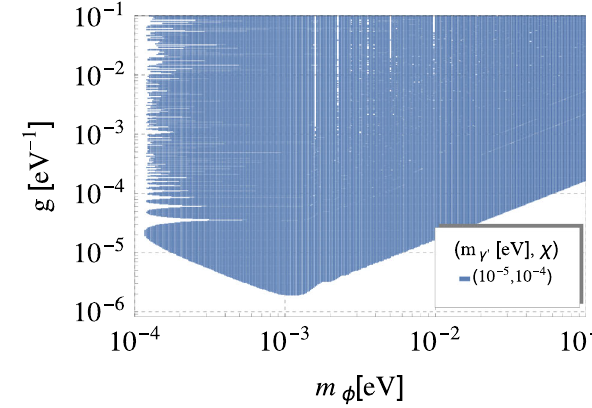
constrained.Rightfigure:thesmallnessof χ preventsforbeingsensitive to small ALP masses. When m φ ∼ 10 − 4 , we have χ 2 m 2 φ L /ω ∼ ψ exp and the experiment can have again some sensitivity to the ALP param- eter space. For both figures we have considered the benchmark values B = 2 . 5 T, L = 1 m and ω = 1